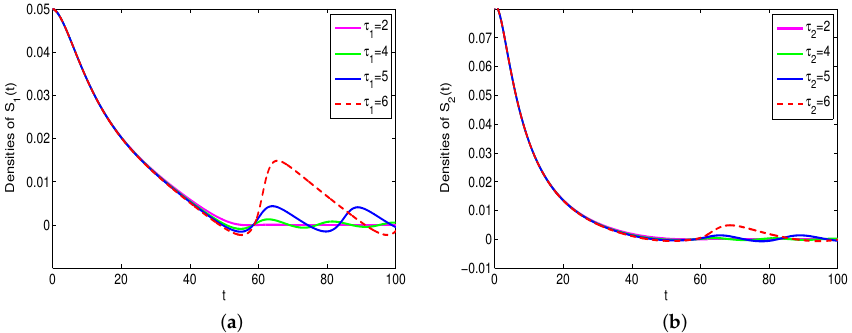
Figure 4. ( a ) The trajectories of S 1 ( t ) with different time delays. ( b ) The trajectories of S 2 ( t ) with different time